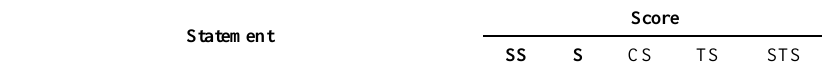
Table A4. Child Depression Symptom